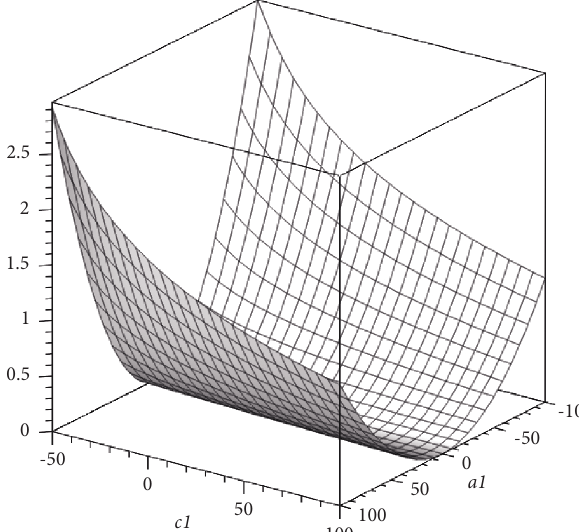
Figure 6: The graph of the data ( a and − 50 ≤ c